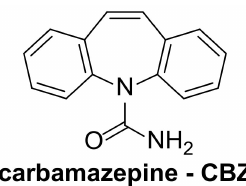
Figure 9. Structure of carbamazepine ( CBZ